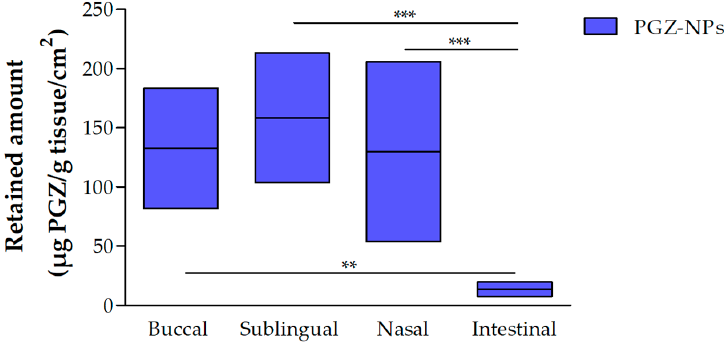
Figure 2. Retained amount of PGZ from nanoparticles (NPs) in different tissues. ( n = 6). One-way analysis of variance (ANOVA) with Tukey’s multiple comparison tests were performed to assess the statistical significance ( p < 0.05).